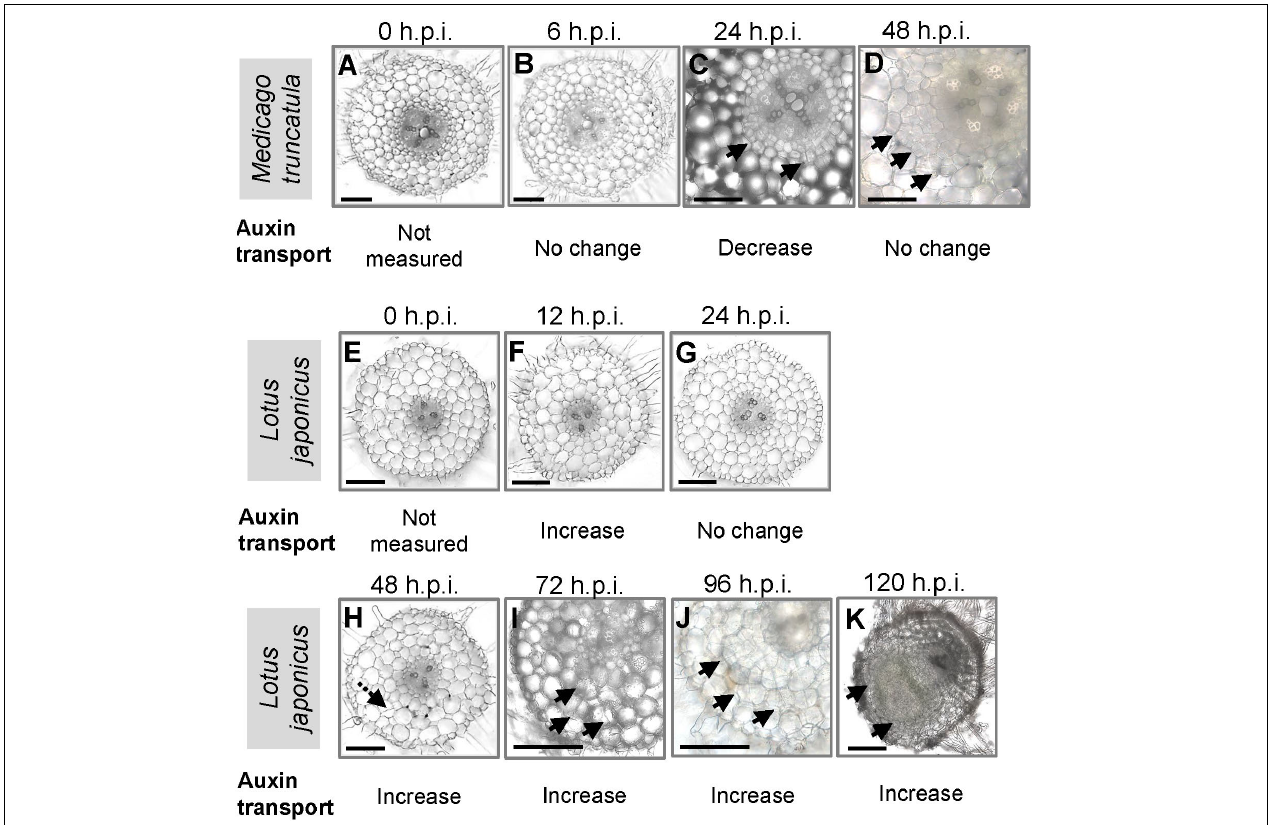
FIGURE 1 | Nodule development in Medicago truncatula and Lotus japonicus . Cross sections of roots showing the stages of nodulation at (A) 0, (B) 6, (C) 24, and (D) 48 h post-inoculation (h.p.i.) in M. truncatula ; cross sections of roots showing the stages of nodulation at (E) 0, (F) 12, (G) 24, (H) 48, (I) 72, (J) 96, and (K) 120 h.p.i. in L. japonicus . Changes in acropetal auxin transport at each individual stage are summarized below each figure. At least 10 roots were examined at each stage. Black arrows indicate pericycle, endodermal, and cortical cell divisions. Dotted black arrow in H indicates a possible cortical cell division. Scale